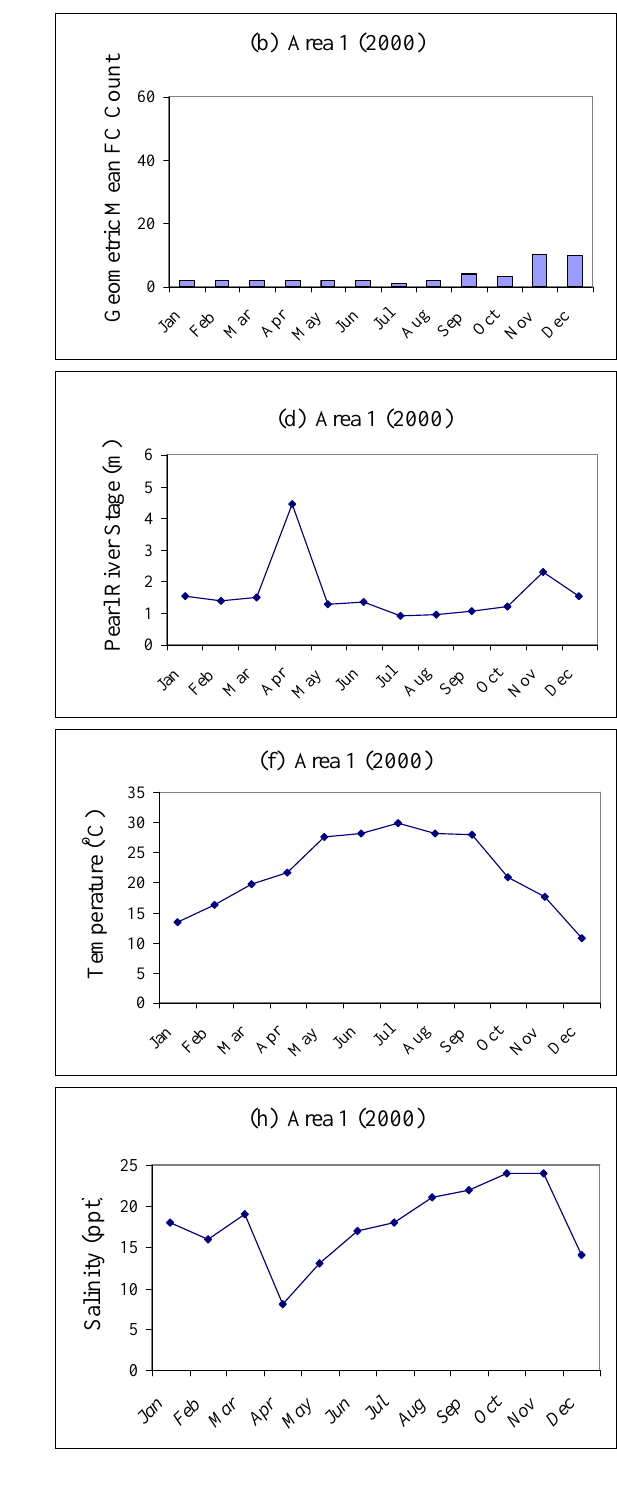
Figure 3: Seasonal variations in the geometric mean fecal coliform abundance, Pearl River stage, water temperature and salinity in the western part of Mississippi Sound in 1999 and 2000. No samples were collected for fecal coliforms, Pearl River stage, water temperature and salinity from May to July